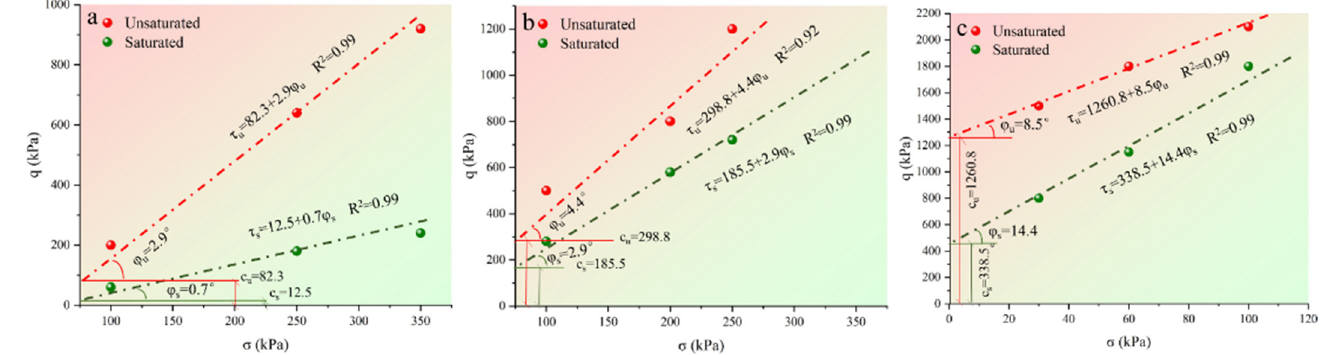
Figure 12. Shear strength envelope: ( a ) pure loess; ( b ) attapulgite-lime-modified loess; ( c ) attapulgite-cement-modified loess.